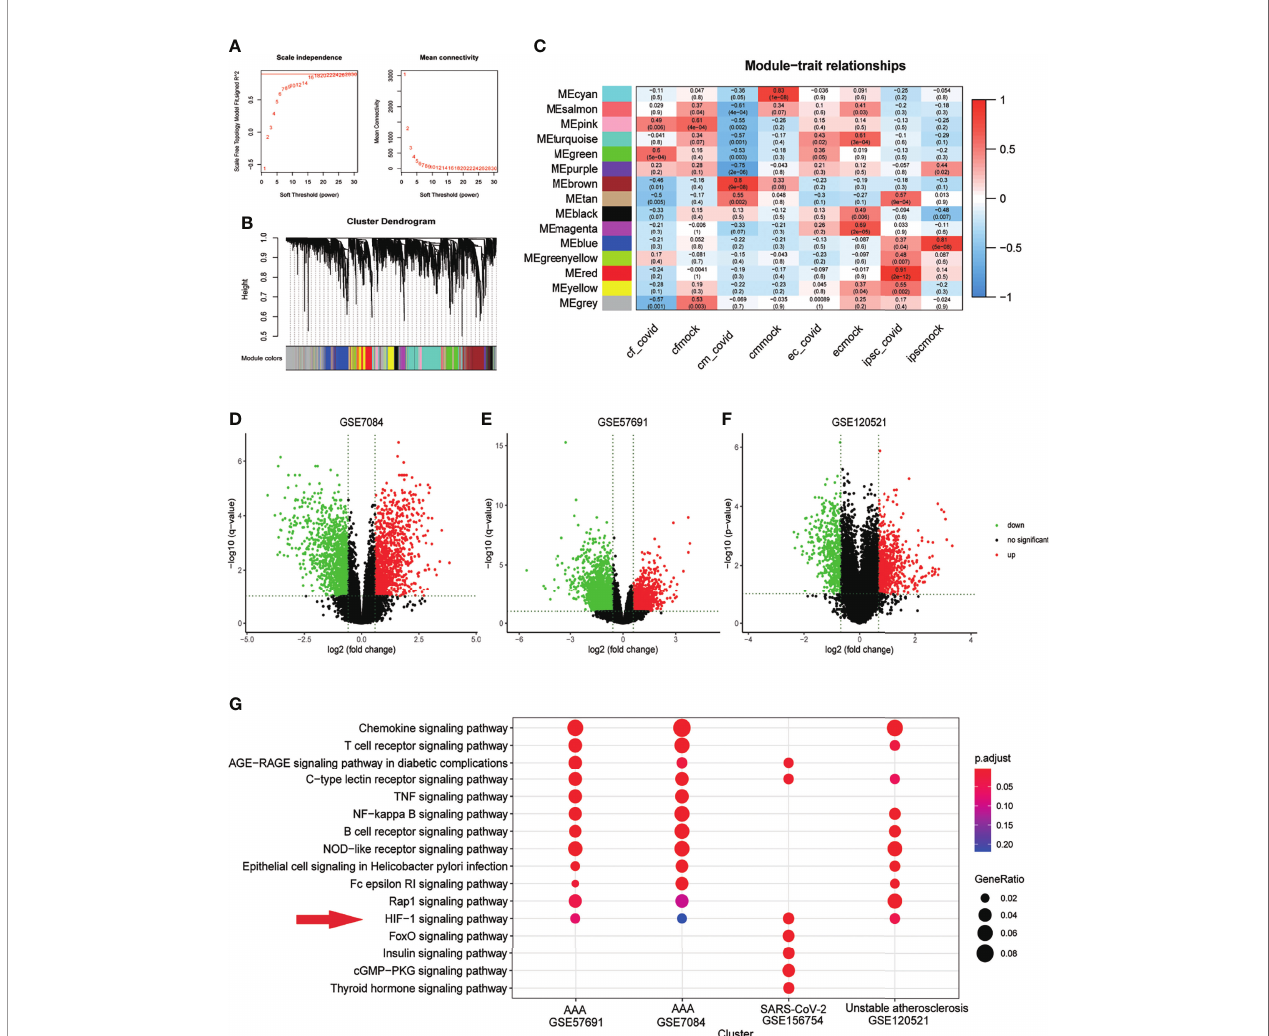
FIGURE 2 | HIF-1 signaling pathway is a key pathway for SARS-COV-2 infection, aneurysm and atherosclerosis. (A) Soft threshold Screening for segmentation of inter gene regulatory network (Power =18) (B) Cluster dendrogram of genes in each module, gray module indicates that the genes have not been assigned to a speci fi c module. (C) Correlation between each module and experimental group, red is positive correlation. The positive correlation module independent of simulated infection is considered as the core module of the corresponding group(cor>0 &Pvalue<0.05). (D) . Volcano plot of differentially expressed genes in GSE7084 (AAA versus normal, Limma, |logFC|>0.5 & q-value<0.1). (E) . Volcano plot of differentially expressed genes in GSE57691 (AAA versus normal, Limma, |logFC|>0.5 & q- value<0.1). (F) . Volcano plot of differentially expressed genes in GSE120521 (Unstable plaque versus stable plaque, Limma, |logFC|>0.5 & p-value<0.1). (G) . Comparison of KEGG enrichment results of differential genes from GSE7084, GSE57691, GSE120521 and GSE156754 (pvalue<0.05). HIF-1 signaling pathway was considered as the key pathway based on signal transduction pathways collected in KEGG database, which was marked with red